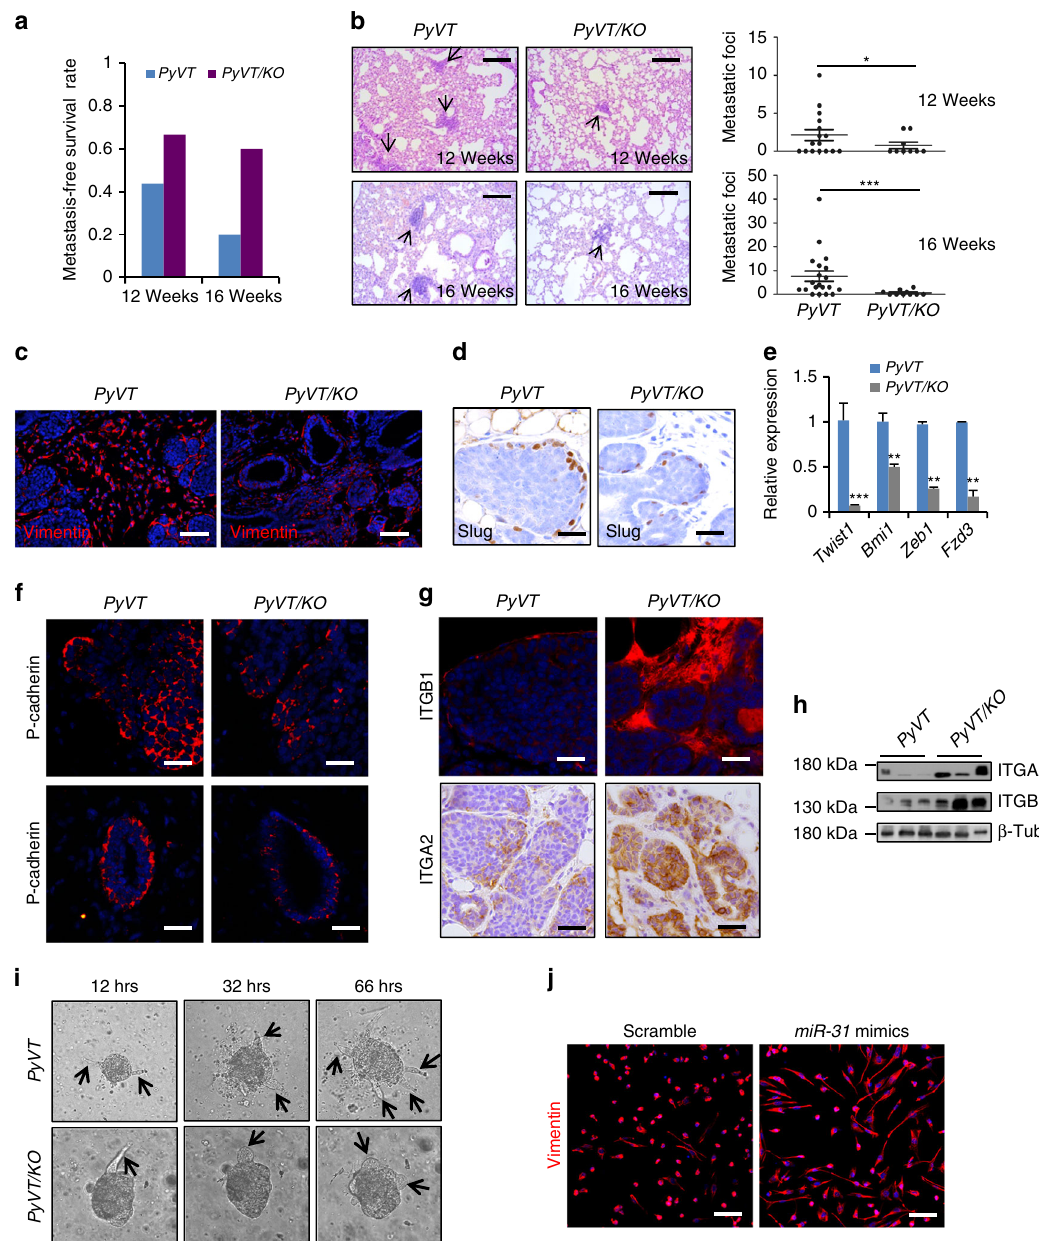
Fig. 6 Loss of miR-31 represses metastasis to the lung. a Quanti fi cation of metastasis-free survival rates of PyVT and PyVT/KO mice at 12 and 16 weeks of age. 12 wks: PyVT ( n = 16), KO/PyVT ( n = 9); 16 wks: PyVT ( n = 20), KO/PyVT ( n = 10). b Representative histology of lungs from PyVT and PyVT/KO mice at 12 and 16 weeks of age. Arrows point to metastatic foci in the lungs. Quanti fi cation of metastatic tumors in the lungs. 12 wks: PyVT ( n = 16), KO/PyVT ( n = 9); 16 wks: PyVT ( n = 20), KO/PyVT ( n = 10). Scale bar, 100 μ m. c Immuno fl uorescence for Vimentin in PyVT and PyVT/KO tumors at 12 weeks of age. Scale bar, 50 μ m. d Immunohistochemistry for Slug in PyVT and PyVT/KO tumors at 12 weeks of age. Scale bar, 25 μ m. e qRT-PCR analysis for Twist1 , Bmi1 , Zeb1 and Fzd3 in PyVT and PyVT/KO tumors at 12 weeks of age. n = 3 biological replicates. f Immuno fl uorescence for P-cadherin in tumors (top panels) and normal mammary ducts (bottom panels) from PyVT and PyVT/KO mice at 12 weeks of age. Scale bar, 25 μ m. g Immuno fl uorescence for β 1-integrin (ITGB1) and IHC for α 2-integrin (ITGA2) in PyVT and PyVT/KO tumors at 18 weeks of age. Scale bar, 25 μ m. h Western blotting for ITGA2 and ITGB1 in PyVT and PyVT/KO tumors at 18 weeks of age. GAPDH was used as a loading control. i Morphology of PyVT and PyVT/KO tumor cells into three- dimensional matrigel culture at indicated time points. Arrows point to protrusions. j Immuno fl uorescence for Vimentin in BT549 breast cancer cells treated with Scramble RNA and miR-31 mimics. Scale bar, 50 μ m. n = 3 technical replicates. Data represented as mean ± S.D. Sample size: PyVT ( n = 3) and PyVT/ KO ( n = 3) for c – i . Two tailed unpaired t -test for e (* P < 0.05; ** P < 0.01; *** P <